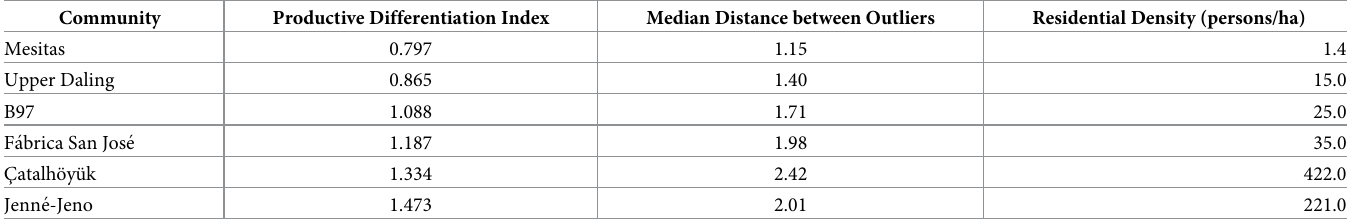
Table 1. Measures of productive differentiation and residential density.